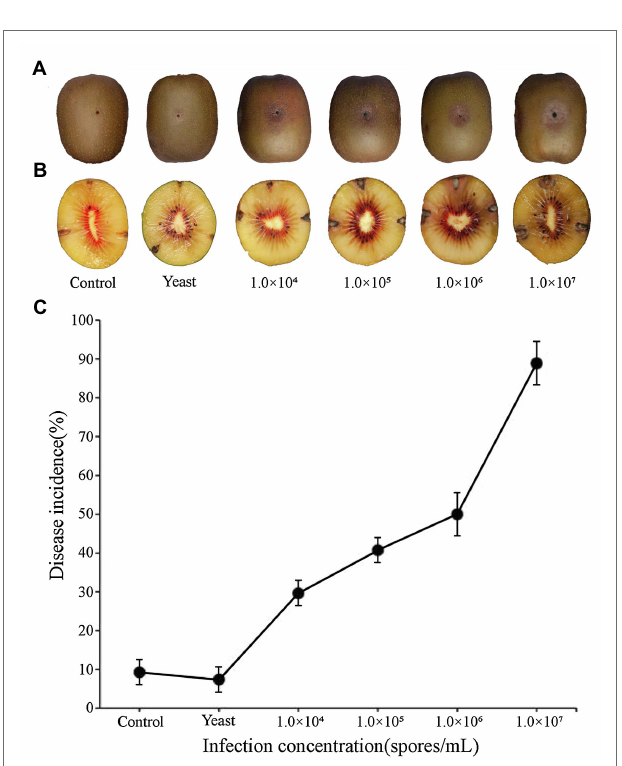
FIGURE 1 | Alternaria alternata (Y784-BC03) morphology. Colony of A. alternata growing on potato dextrose agar (A) after 4 days of culture. Conidia of A. alternata (Y784-BC03) at a magnification of ×100 (B) .